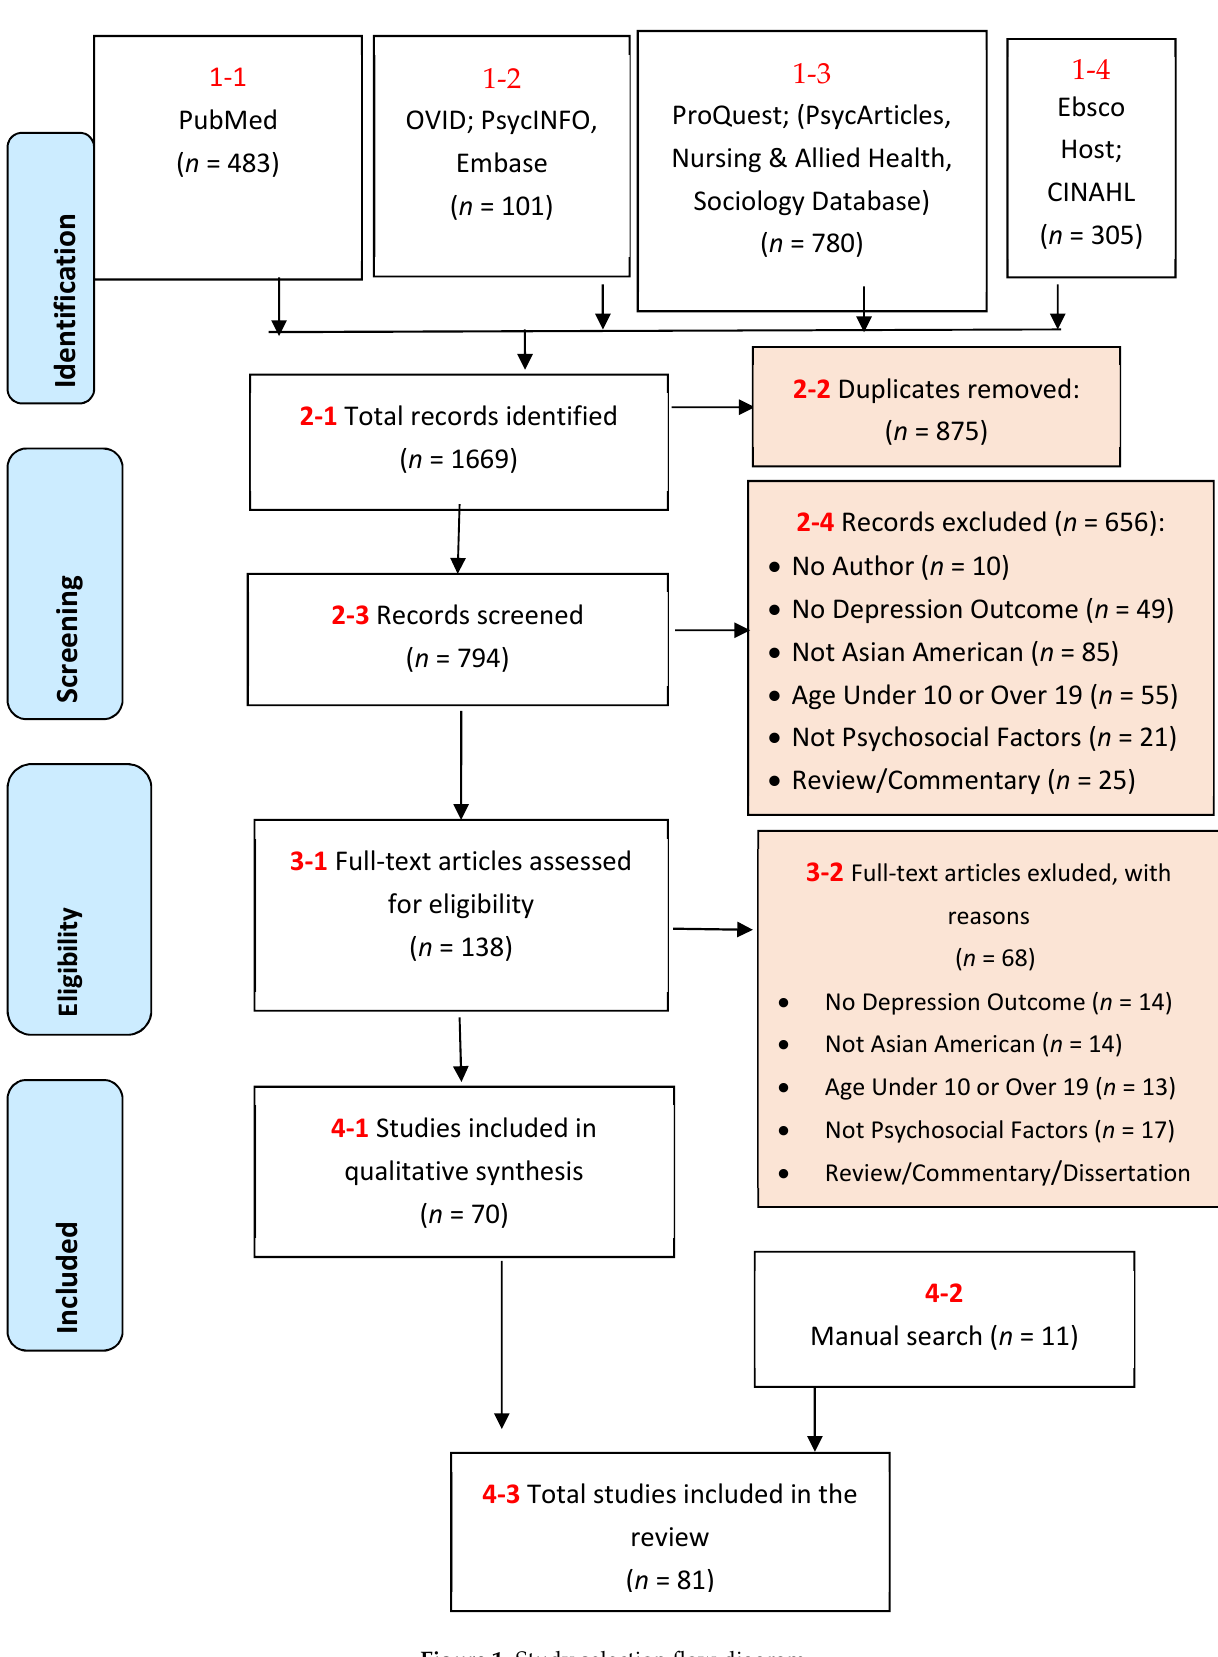
Figure 1. Study selection flow diagram.